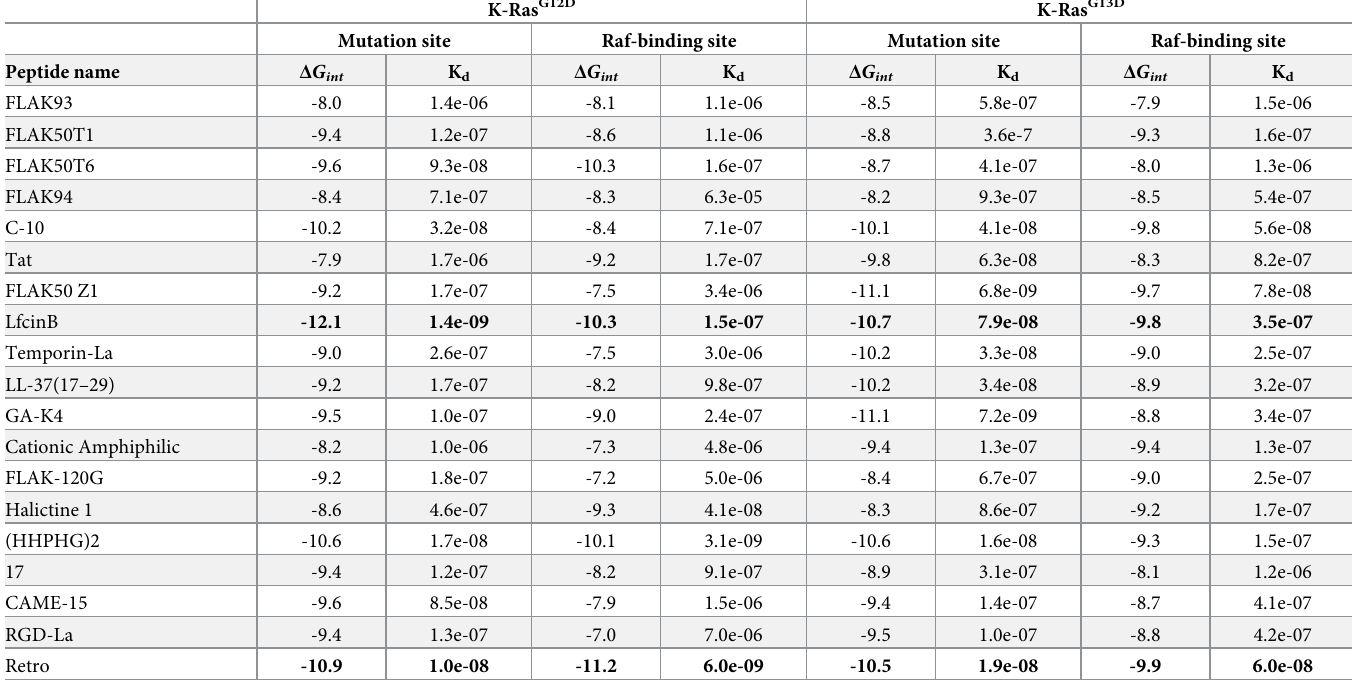
Table 3. Results of docking between peptides and K-Ras G12D and K-Ras G13D . Values of Δ G int and K d are presented based on kcal mol -1 and molar, respectively. Peptides with highest binding affinity to corresponding interfaces of the proteins are shown in